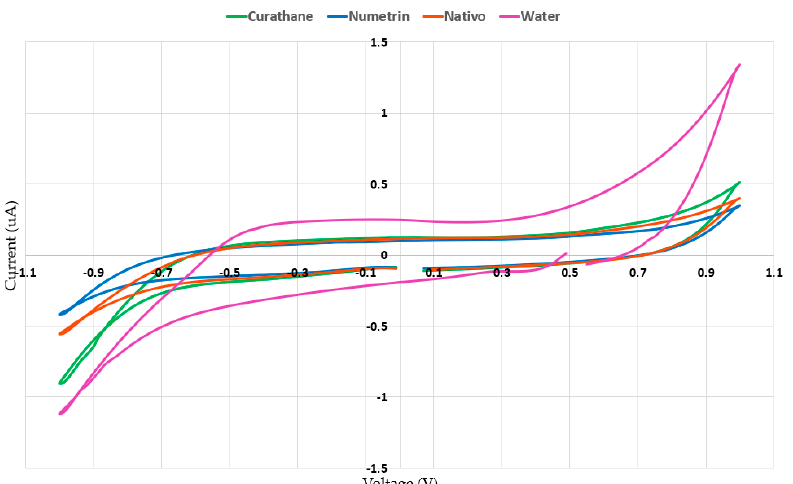
Figure 2. Cyclic voltammograms acquired through a bipotentiostat using the carbon sensor (C110) to detect pesticides (Curathane, Numetrin, and Nativo) and distilled water.